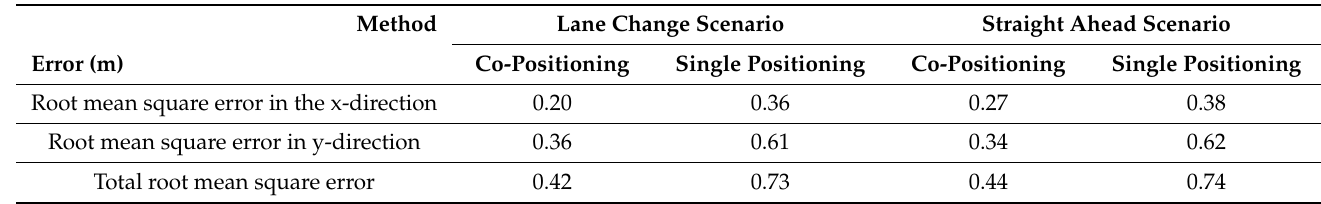
Table 1. The average value of the error in the time domain for the two positioning